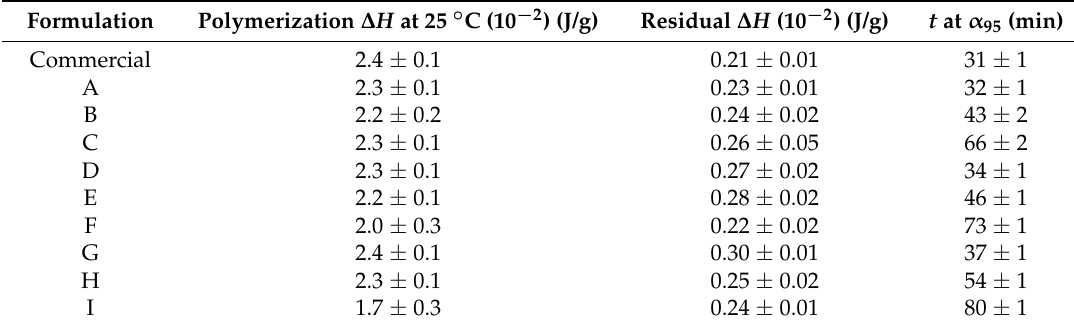
Table 2. Polymerization heat, residual heat and t at α 95 determined by isothermal DSC studies from commercial to I